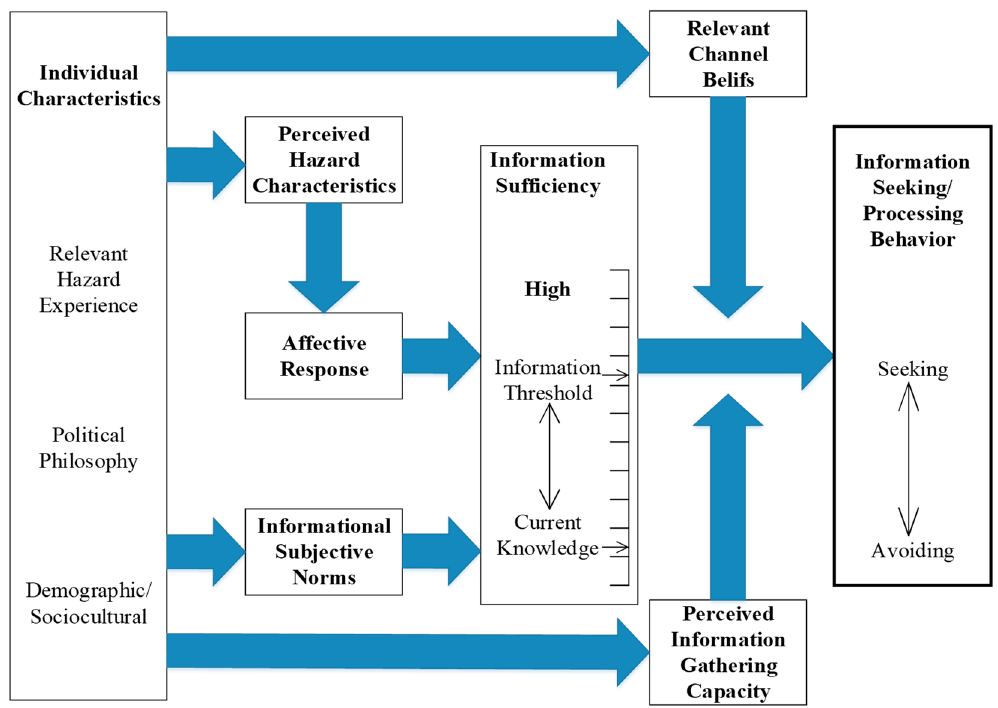
Figure 1. Model of risk information seeking and processing from the original model by Griffin et al. (1999) [11].